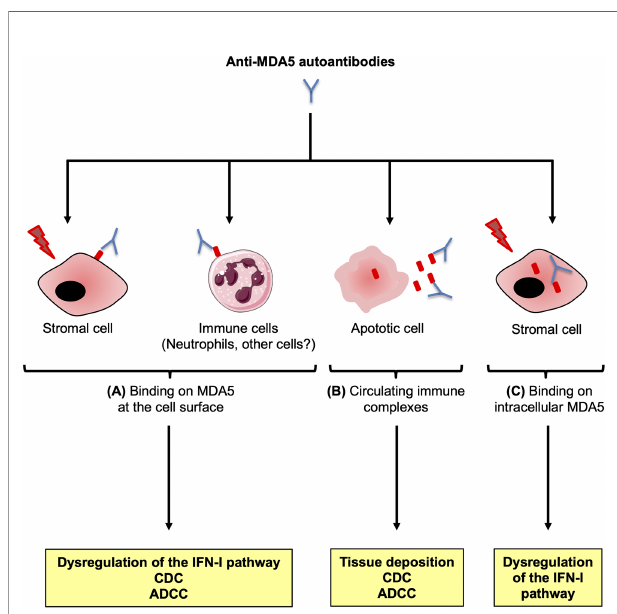
FIGURE 5 | Potential contribution of the anti-MDA5 antibodies to the pathogenesis. Anti-MDA5 antibodies (Abs) may contribute to the pathogenesis in several ways. (A) In speci fi c conditions, MDA5 may translocate at the surface of critical stromal cells, or immune cells such as neutrophils. Interaction between the autoAb and the ectopic antigenic target could trigger chronic activation of the type I interferon (IFN-I) signaling pathway, as well as immune mediated cytotoxicity through complement activation (CDC) and/or Ab-dependent cytotoxicity (ADCC). (B) Anti-MDA5 Abs could also bind to MDA5 released from apoptotic cells, to form immune complexes that could contribute to immune-mediated damage. (C) A cell exposed to a stress (infection, genetic background) overexpresses intracytoplasmic MDA5. Anti-MDA5 Abs might penetrate the cell to bind to MDA5, altering several functional